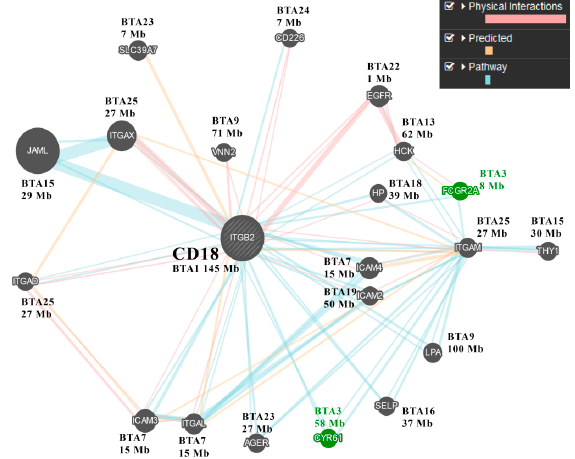
Figure 2. Gene network of the ITGB2 (CD18) gene. Connections between nodes were based on protein–protein interaction data, predicted functional relationships between genes, and gene-pathway data produced by the GeneMANIA system using ITGB2 as the input gene and the Homo sapiens database. On the output of this prediction server, next to the gene nodes, the orthologous bovine autosome numbers and positions were annotated. The nodes of genes with positions coinciding with BTA3 are highlighted in green.